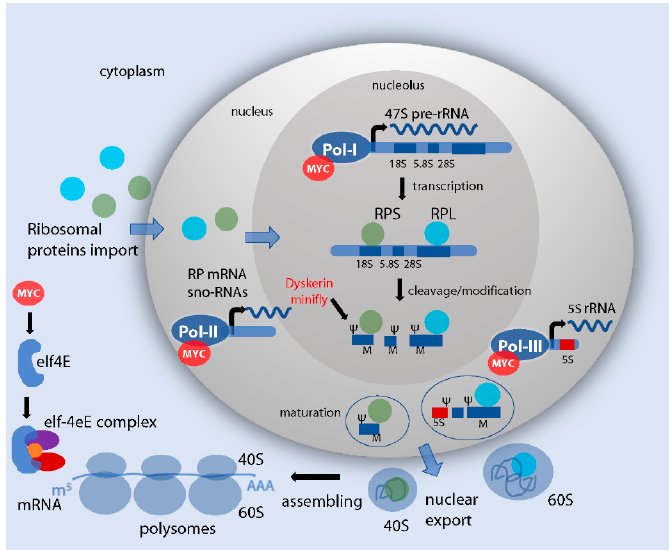
Figure 1. Control of ribosome formation and RNA translation. Schematic representation of the essential steps in ribosome biogenesis in humans and of the relative regulation by Myc (in red). In the nucleolus, interacting with the complex Pol-I, Myc increases rDNA transcription and the formation of pre-rRNAs. The pre-rRNA is then processed and cleaved to form the 18S, 5.8S and 28S. These RNAs are assembled with ribosomal proteins (RPs) with the assistance of snoRNAs that mediate important RNA modifications—in particular, small nucleolar RNAs belonging to those of box C / D mediate O-methylation (M) and to those of the box H / ACA pseudourydilation ( Ψ ). In these steps, Myc activity controls Pol-II for the transcription of snoRNAs and specific RPs. Of note: in Drosophila, Myc was shown to directly control the expression of the snoRNP dyskerin (in flies called minifly , reviewed in 2.3, due to its phenotype that is reminiscent of that of diminutive mutants, reviewed in 2.1). The pre-assembled ribosomal units form the premature 40S and 60S subunits in the nucleolus. In the nucleus, the activity of Pol-III to encode for the 5S rRNA, necessary for the proper maturation and the assembly of the 60S subunit, has been associated with Myc activity. The two mature subunits are then exported into the cytoplasm and assembled into mature ribosomes or polysomes, ready to perform translation of mRNAs and protein synthesis. In the cytoplasm, the translation is initiated with the formation of the initiation factor 4F (eIF4F) complex, that includes the cap-binding protein eIF4E, the sca ff olding protein eIF4G (in purple) and the helicase eIF4A (in red) [14]. Myc in humans promotes the translation of eIF4F, and cooperates with elF4E to drive tumorigenesis in vivo